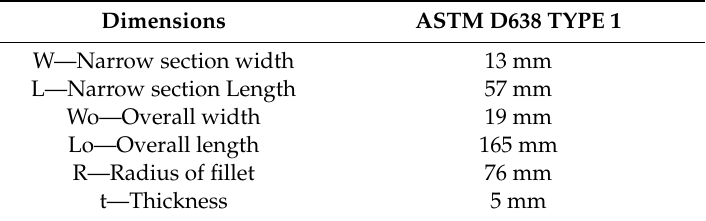
Figure 3. Sketch of TYPE 1 ASTM D638 specimen for the tensile test. Table 1. Dimensions of the designed specimen shown in Figure 3, according to ASTM D638.